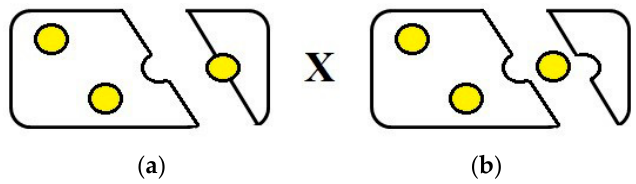
Figure 2. Schematic representation to differentiate the two filler particles: ( a ) Active particles and ( b ) Inactive particles.